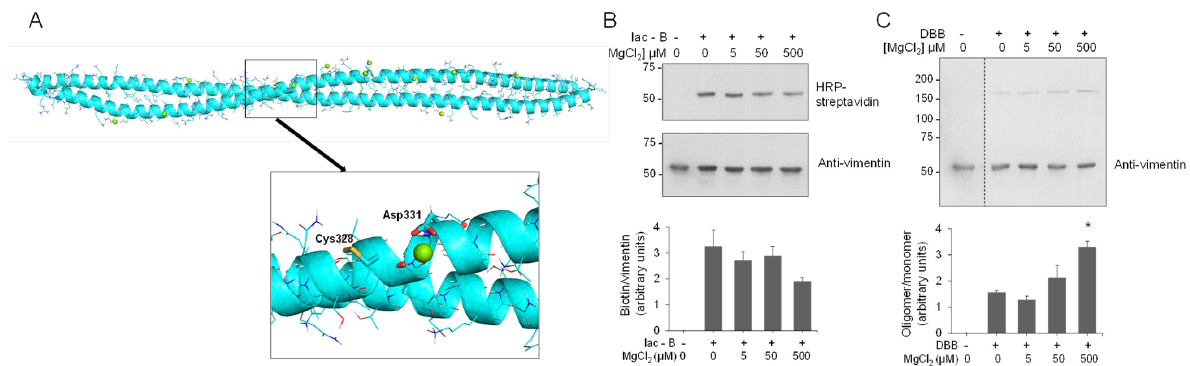
Figure 7. Interaction of magnesium with the vimentin dimer and effect on cysteine crosslinking. ( A ) Final snapshot of the MD simulation of vimentin dimer B in the presence of magnesium atoms (green spheres). The lower panel shows an enlarged view of the region surrounding Cys328. ( B , C ) Effect of magnesium on vimentin chemical modification by Iac-B ( B ) or crosslinking by DBB ( C ). Vimentin wt (4.3 μ M final concentration) was incubated with vehicle or MgCl 2 at the indicated concentrations for 1 h, at r.t, after which 10 μ M Iac-B ( B ) or 24 μ M DBB ( C ) were added for 30 min or 1 h, respectively, at r.t. Graphs in the lower panels show mean values ± SEM of at least three independent experiments. * p < 0.05 vs. DBB by unpaired Student’s t -test.